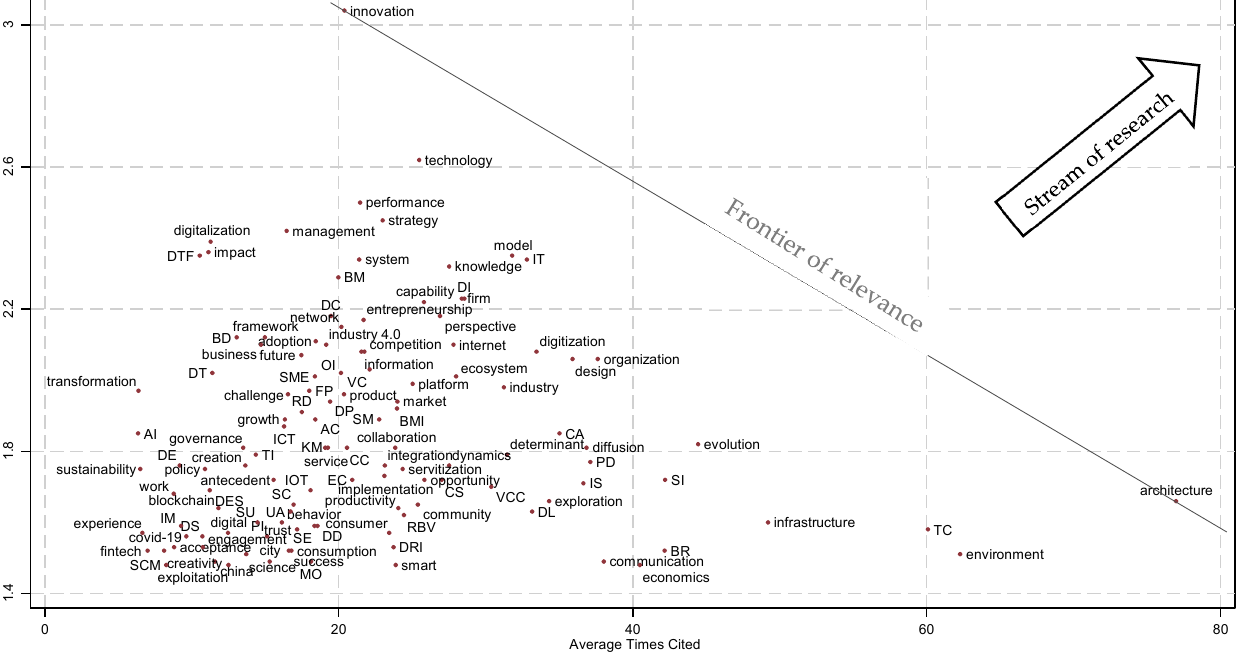
Figure 7. Analysis of streams of research on the most prominent clusters. Furthermore, according to Figure 7, Cluster 1 and Cluster 2 are potentially important streams of digital transformation and innovation research, as they are trending toward the top right of the graph. Figure 6 also shows that Cluster 5 (entrepreneurship and digital technology) never reached the high level of relevance in academic research that the other clusters have, according to citations.